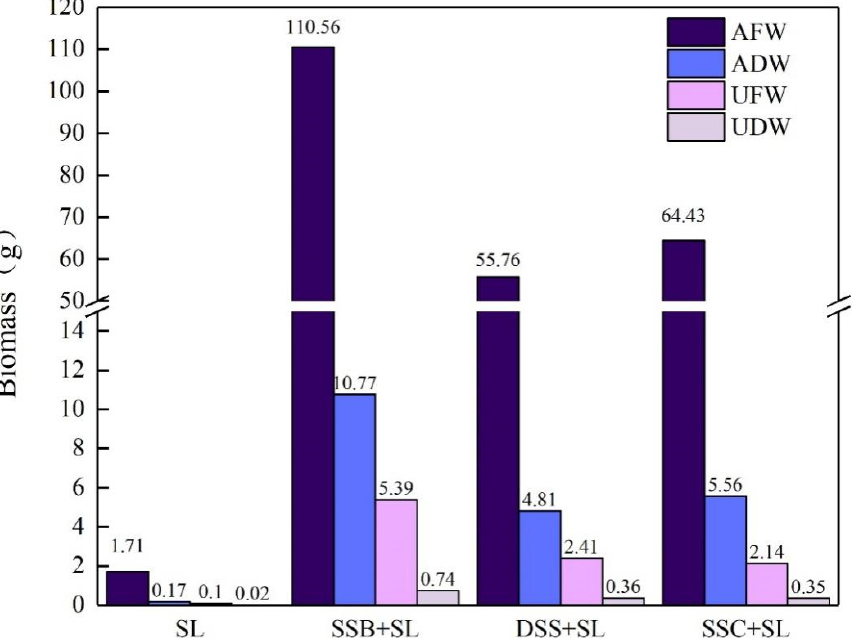
Figure 4. Germination rate and plant height of Chinese cabbage grown with four different sample soils.